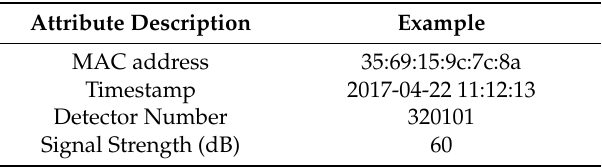
Table 1. List of collected Wi-Fi signal data attributes.